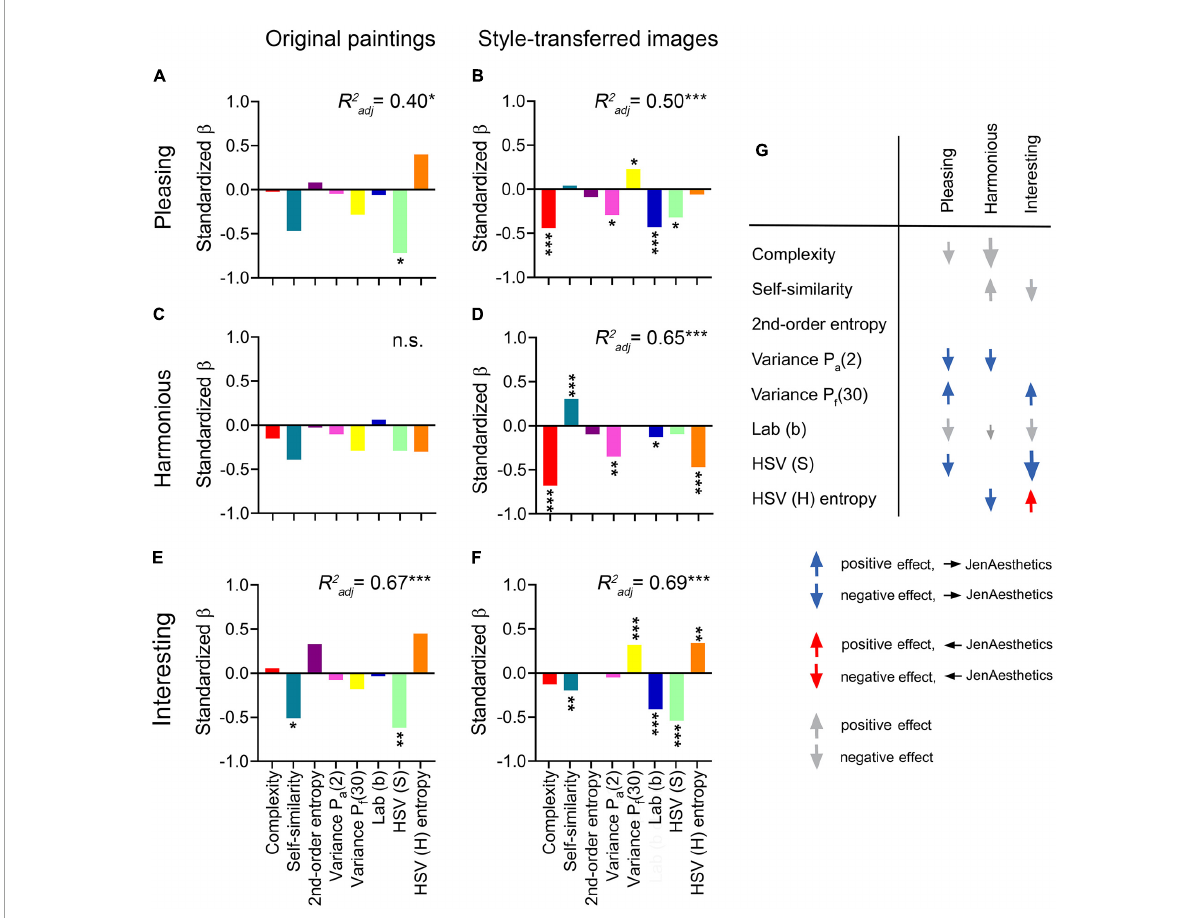
FIGURE7 Standardized β ( β ∗ ) values for the influence of the statistical image properties (SIPs) on the rating responses. Data are shown for original artworks (A,C,E) and style-transferred images (B,D,F) . The three rating dimensions are Pleasing (A,B) , Harmonious (C,D) and Interesting (E,F) . The explained variance ( R 2 adj ) of the respective model is indicated on top of each panel. Asterisks indicate β ∗ values of variables that had a significant effect on the ratings when the other variables were controlled for; the respective significance levels are * p < 0.05; ** p < 0.01; *** p < 0.001. n.s., not significant. (G) Influence of the SIPs on the rating responses, in relation to the JenAesthetics dataset. This overview summarizes results for the ratings of the style-transferred images for all participants (A–F) . The influence of the eight independent variables (SIPs) on the ratings (Pleasing, Harmonious, and Interesting) is represented by arrows, which are shown only for those variables that had a significant effect on the ratings when the other variables were controlled for [marked by asterisks in (B,D,F) and Supplementary Table 2 ]. The size of the arrows indicates the strength of the relation [small arrows, | β ∗ | < 0.2 (weak effect); medium-sized arrows, 0.2 ≤ | β ∗ | < 0.5 (moderate effect); and large arrows, | β ∗ | ≥ 0.5 (strong effect)]. The direction indicates the sign of the relation (upward, positive relation; and downward, negative relation). The colors indicate the changes relative to the results for the JenAesthetics data set ( Figure 4 ). Blue arrows indicate higher ratings if the SIPs are closer to the mean SIPs of the JenAesthetics data set. Red arrows indicate higher ratings if the SIPs are more distant from the mean SIPs of the JenAesthetics data set. Gray arrows indicate no significant differences of the SIPs between the style-transferred images and the JenAesthetics data